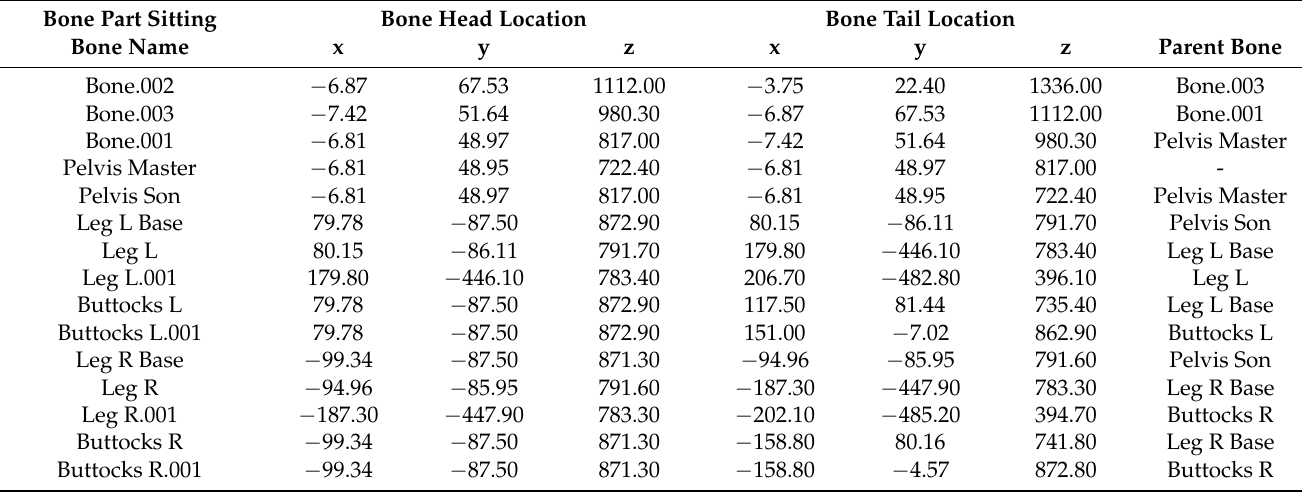
Table 3. Armature’s absolute x, y and z coordinates for every bone’s head and tail in Blender 3D, for the sitting posture of a sitting